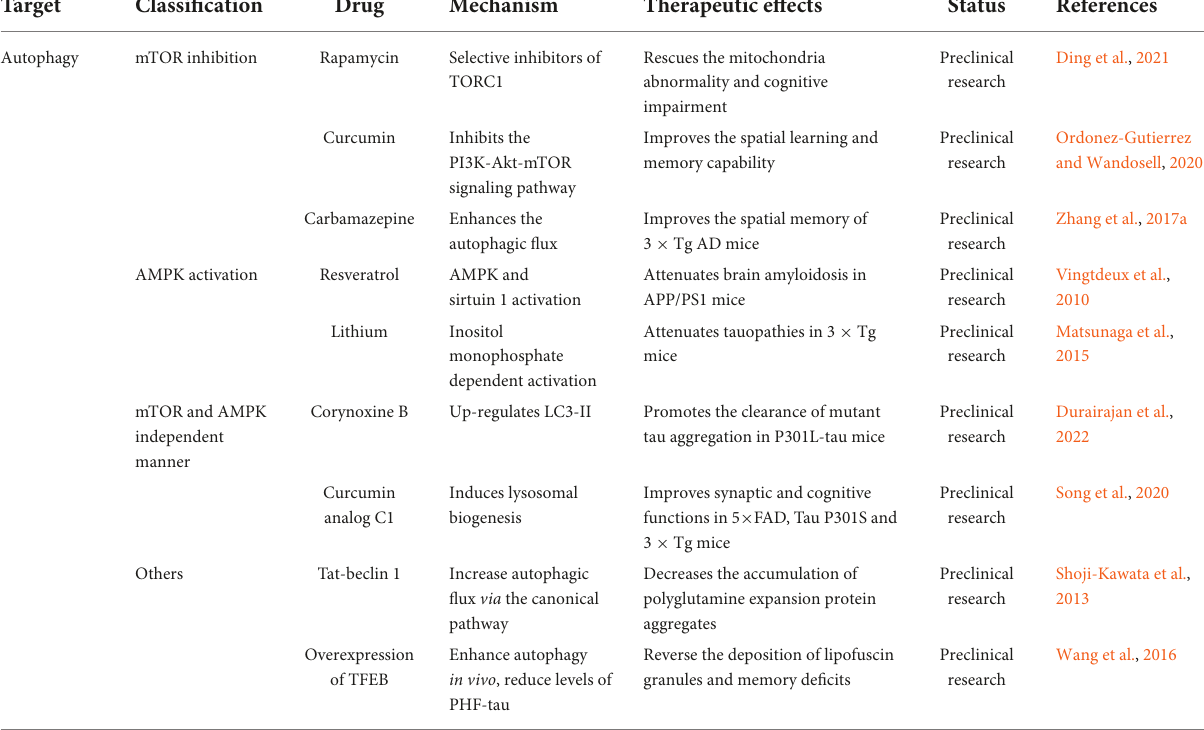
TABLE 1 Alzheimer’s disease (AD) therapeutic strategies targeting